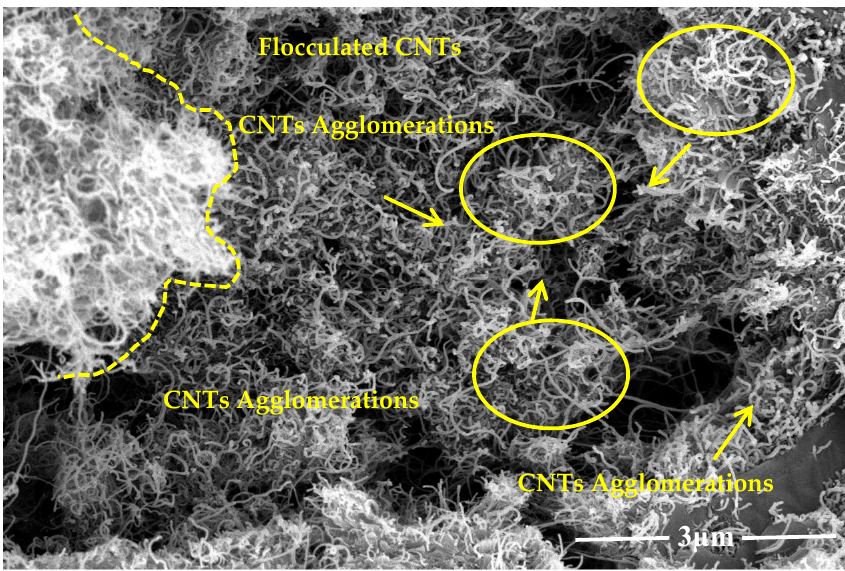
Figure 2. Carbon nanotubes (CNTs) agglomeration without surfactant.